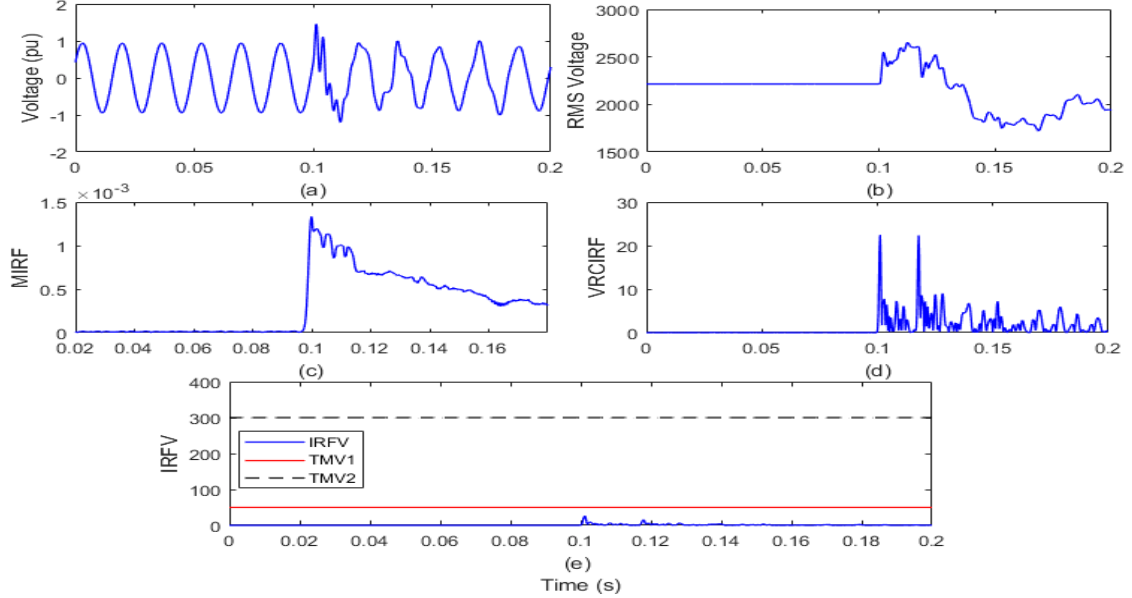
Figure 14. Synchronization of wind power plant (WPP) to grid ( a ) voltage signal ( b ) root means square value of voltage ( c ) median-based IRF ( d ) rate of change in voltage-based IRF ( e ) islanding recognition factor based on voltage.